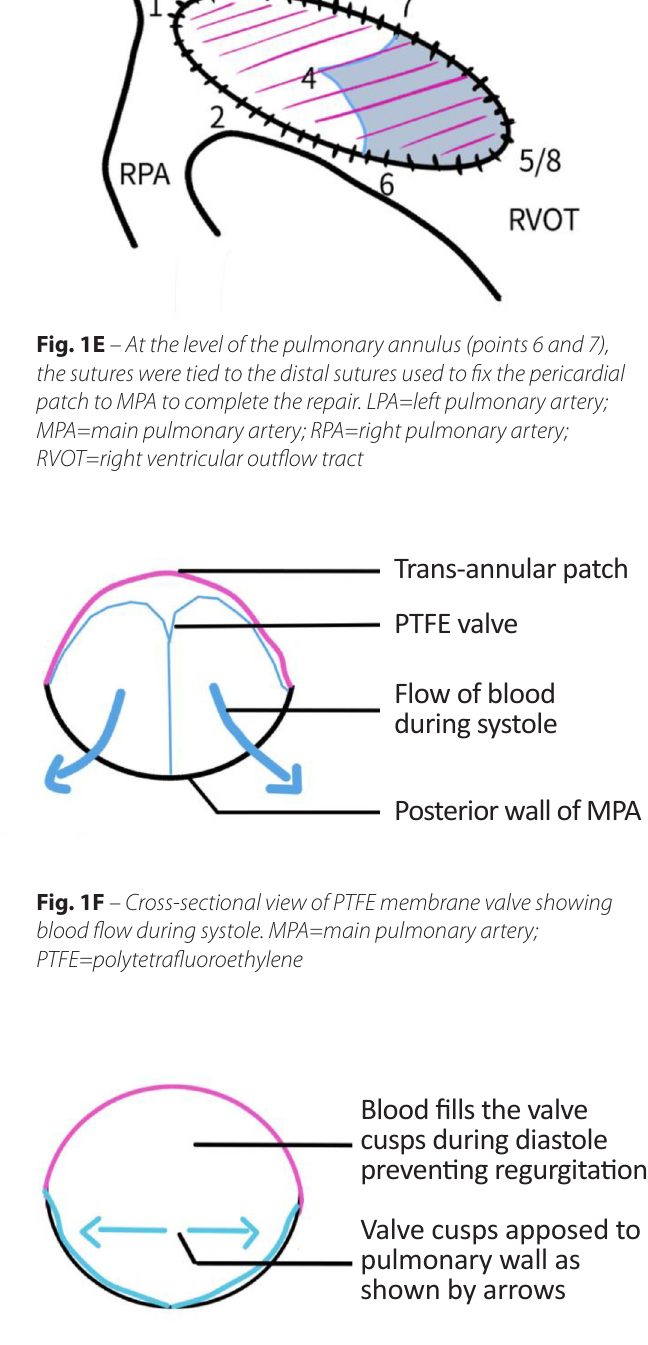
Fig. 1G – Cross-sectional view of PTFE membrane valve during diastole. PTFE=polytetrafluoroethylene